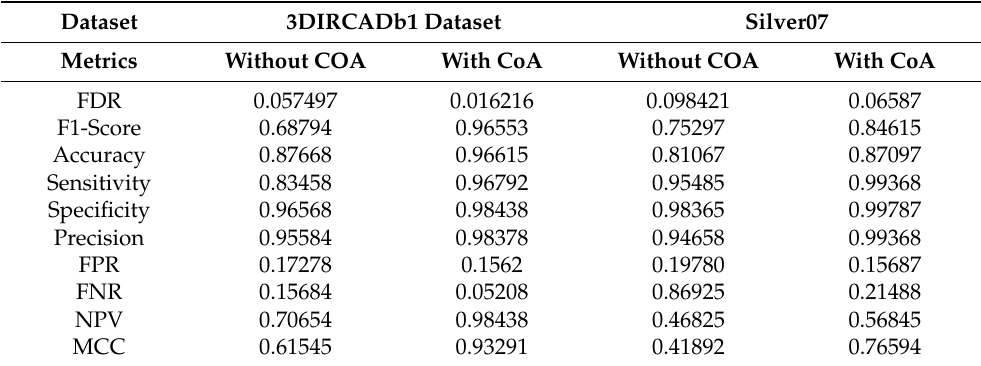
Table 10. Comparative analysis of the proposed ELM with and without